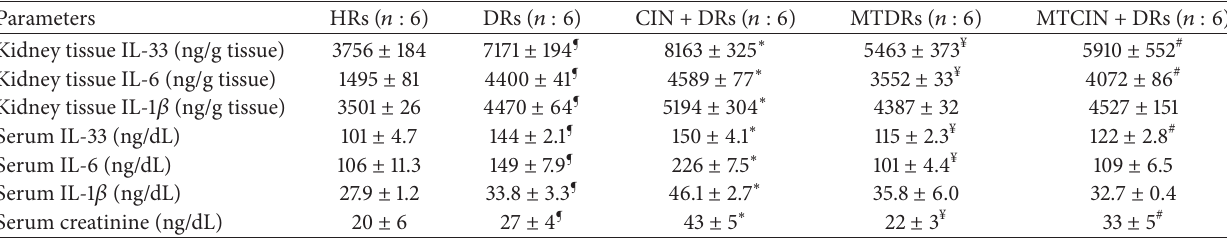
Table 1: Serum and kidney tissue levels of interleukins among groups.